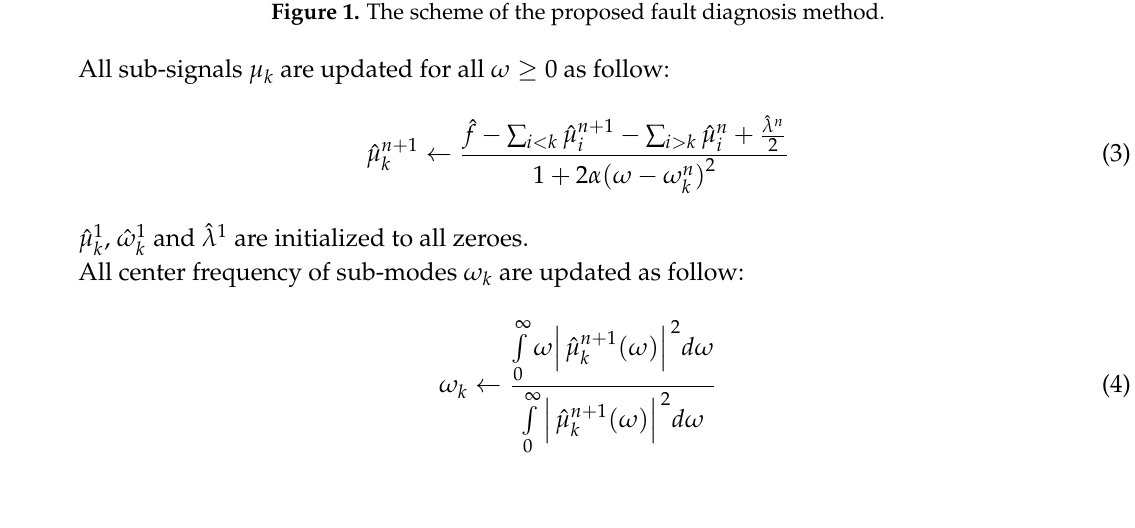
Figure 1. The scheme of the proposed fault diagnosis method.